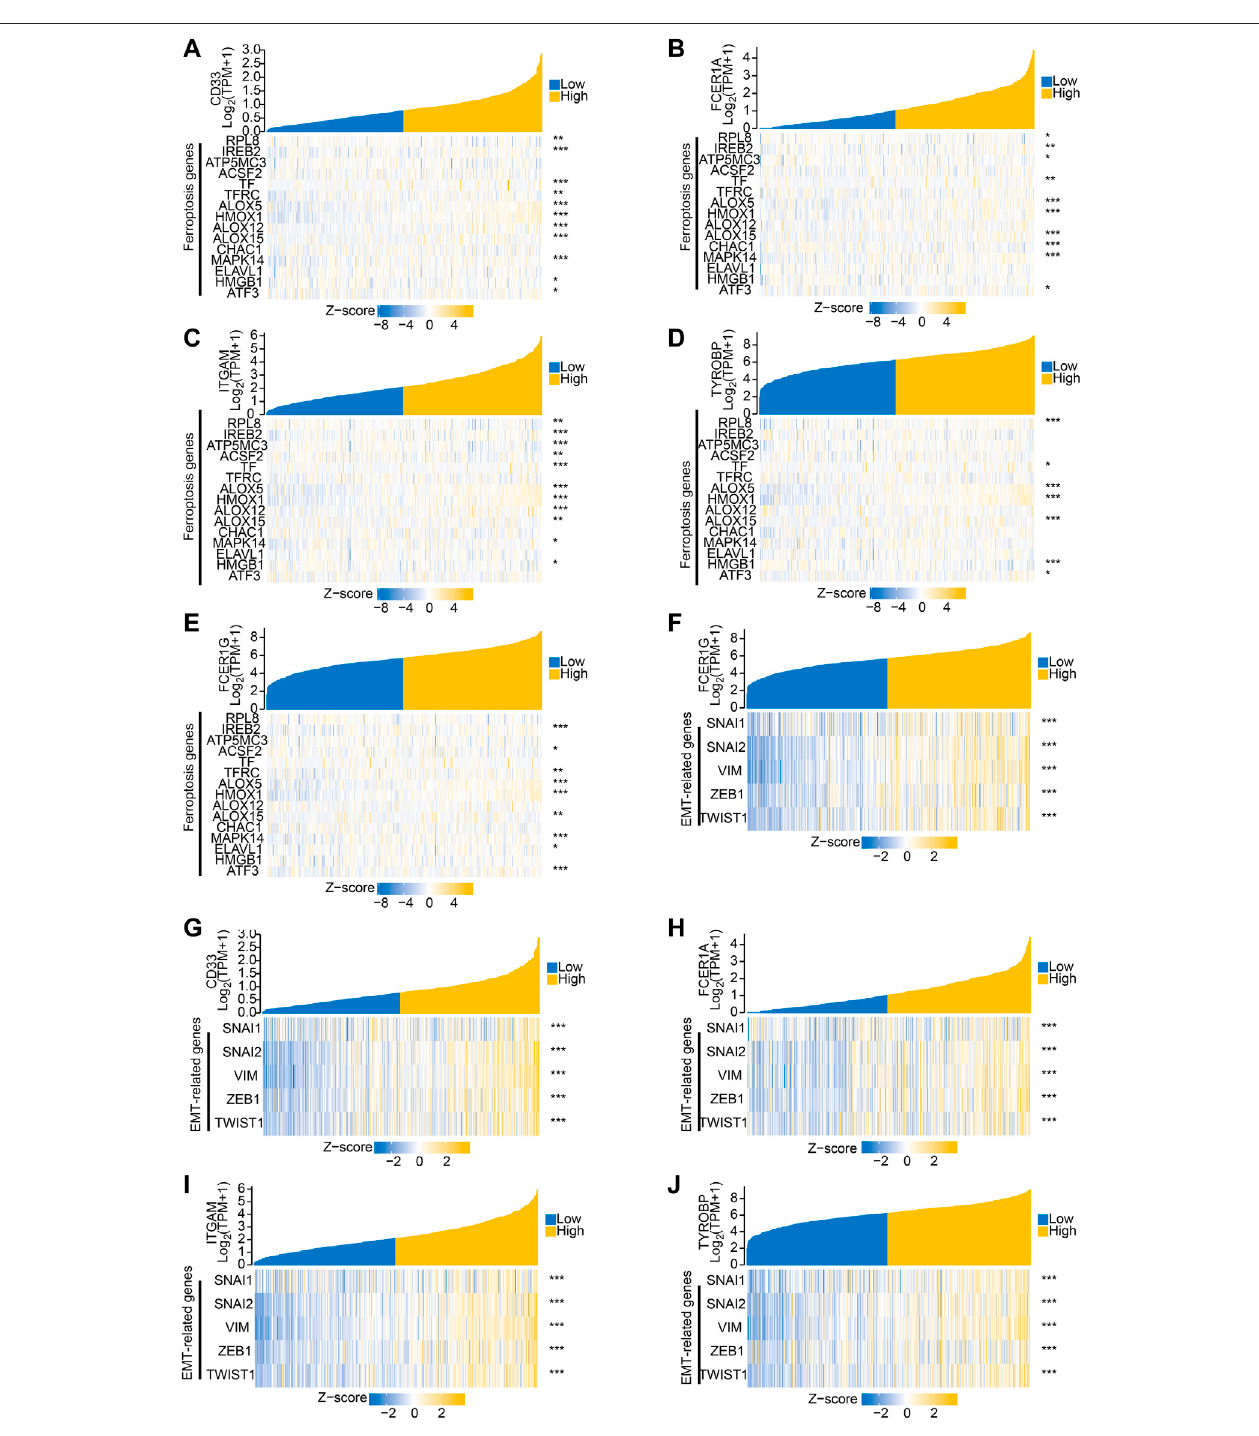
FIGURE 8 | Hub genes associated with both ferroptosis and invasive migration. The correlation between CD33 (A) , FCER1A (B) , ITGAM (C) , TYROBP (D) , FCER1G (E) and ferroptosis geneswasconducted and presented withSingle geneco-expressionheatmap; Thecorrelationbetween FCER1G (F) , CD33 (G) , FCER1A (H) , ITGAM (I) , TYROBP (J) and EMT-related genes was performed and shown with Single gene co-expression heat map.